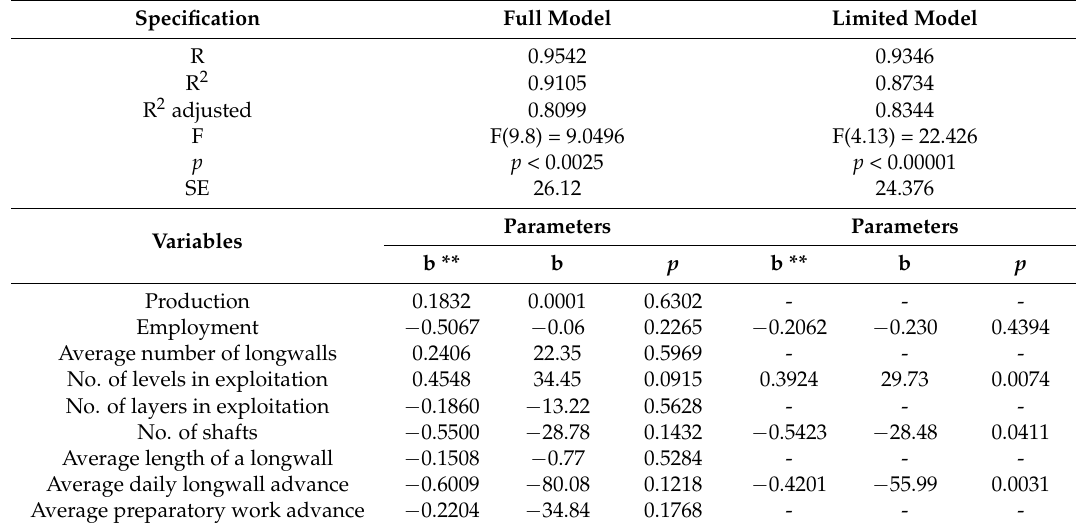
Table 2. Regression models for